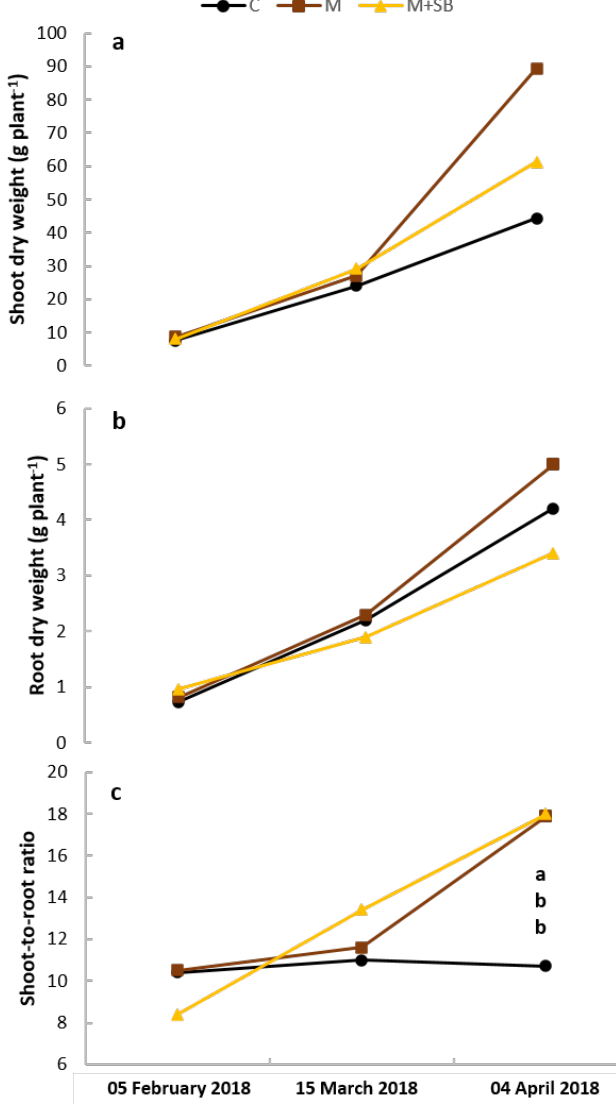
Figure 9. Biomass expressed in dry weight (g plant − 1 ) of shoots ( a ), roots ( b ) and shoot-to-root ratio ( c ) as a function of organic amendments (none (C), manure (M) and manure plus rice straw buried (M + SB)) at three crop stages (vegetative/flowering, pod development and maturity) in the 2017/18 dry season. When different letters are shown, these indicate statistically significant differ- ences between treatments. The order of the letters from top to bottom correspond with the order in which treatments are presented in the legend.